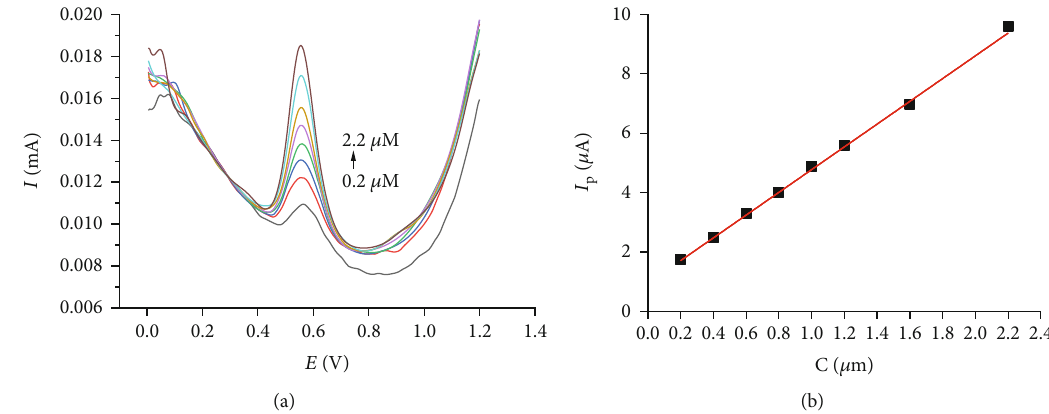
Figure 11: DPV curves of DCF with di ff erent concentrations (0.2 – 2.2 μ M) in 0.2M BRS pH6.5 at the modi fi ed electrode (a). The plot of I vs. concentration